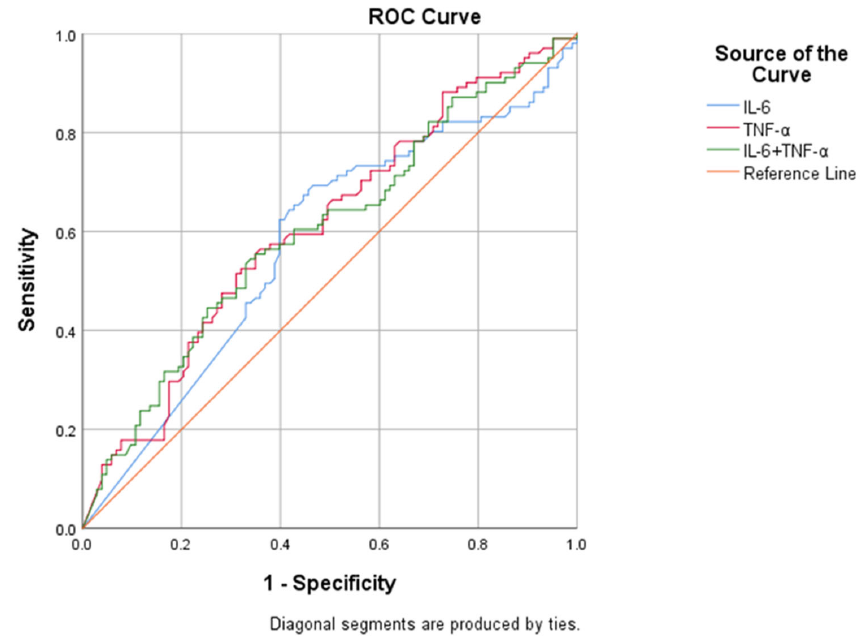
Figure 4. The risk forest plot of the relationship between IL-6, TNF- α and the prognosis of moyamoya disease and the ROC curve of the stepwise regression model.